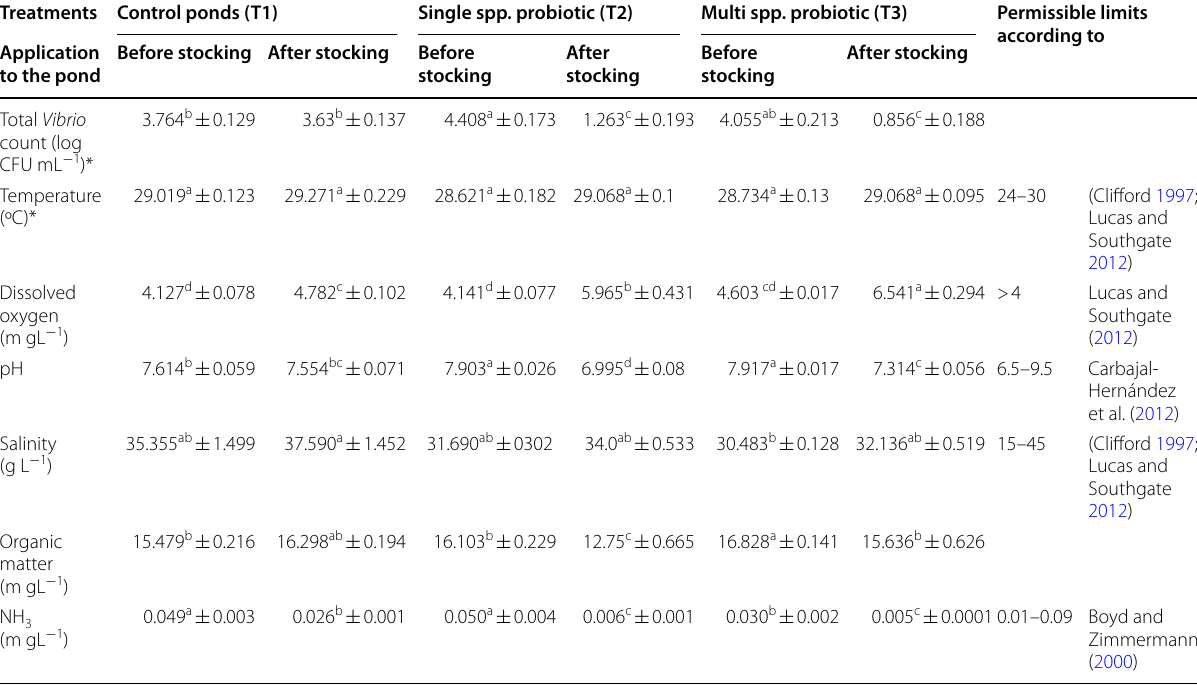
The means with different superscript letters within the same row for each parameter are significantly different at *P Table 3 Correlations coefficient between different water quality parameters in the examined pond with or without probiotic